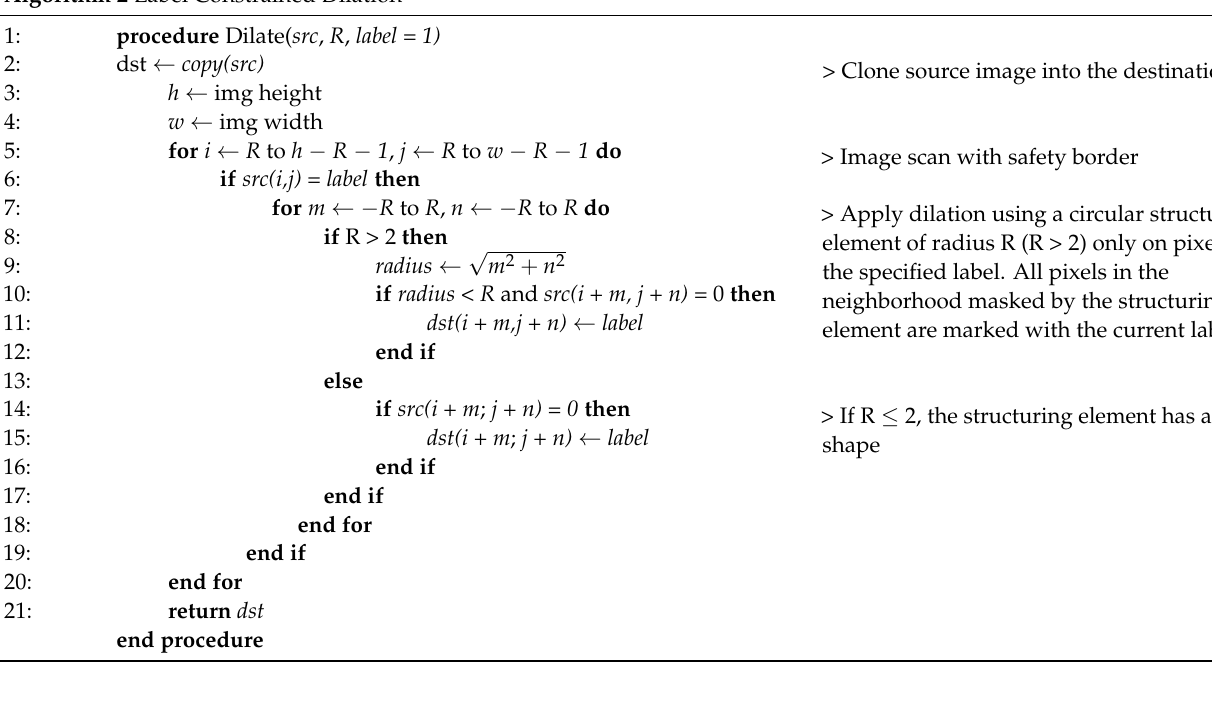
Algorithm 2 Label Constrained Dilation